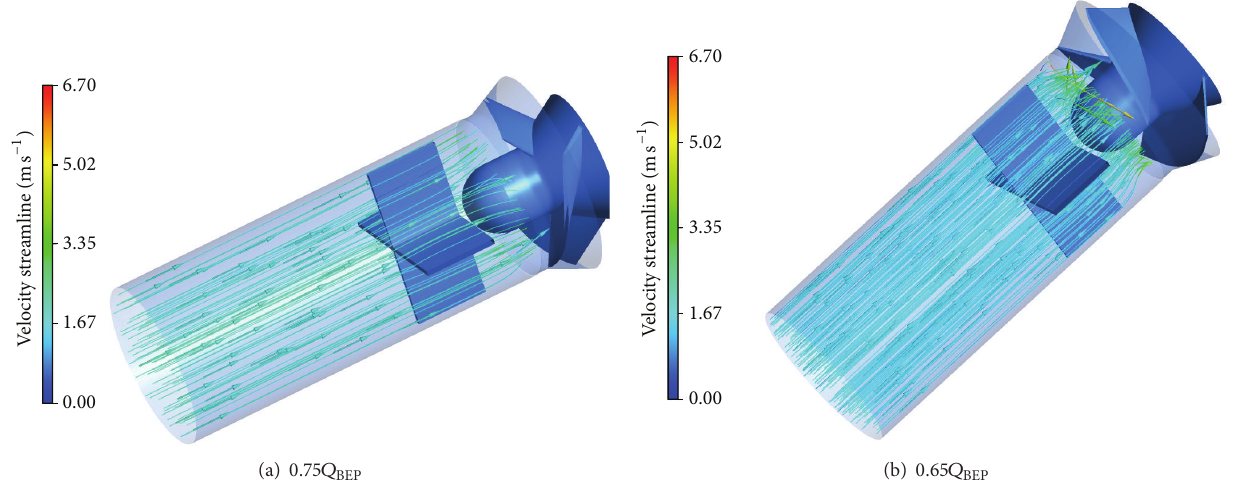
Figure 7: Velocity streamline at the upstream of the impeller with a swirl-stop.